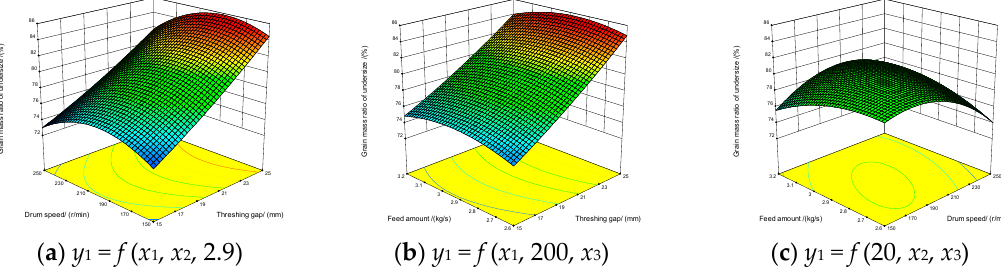
Figure 12. Influence of interaction factors on the grain mass ratio of undersize